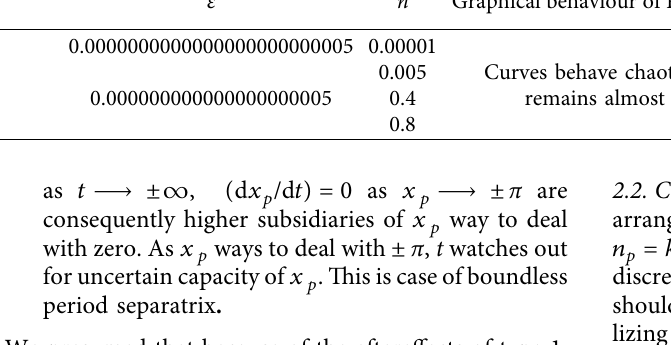
ε n Graphical behaviour of Poincare map Graphical behaviour of Lyapunov